Question: Which visualization type does this figure use?
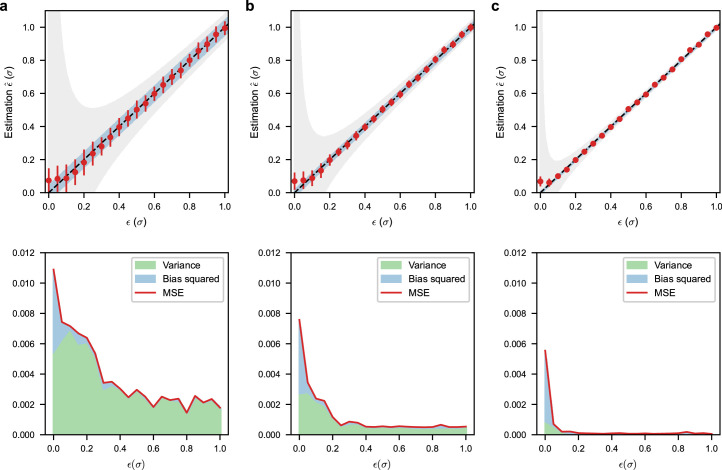
Answer: bar